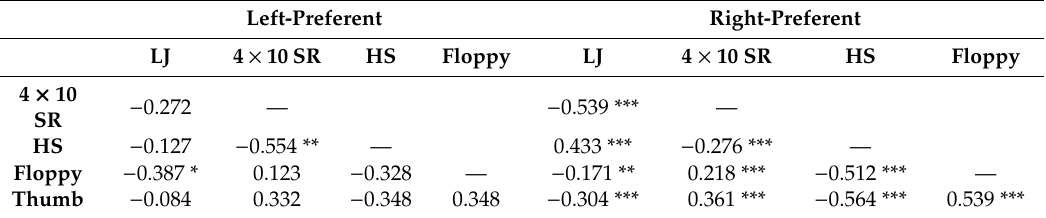
Table 4. Correlation matrix of motor tests stratified by hand preference. The sample size of right-handed children, as compared to left-handed ones, was considerably higher, biasing the statistical significance.